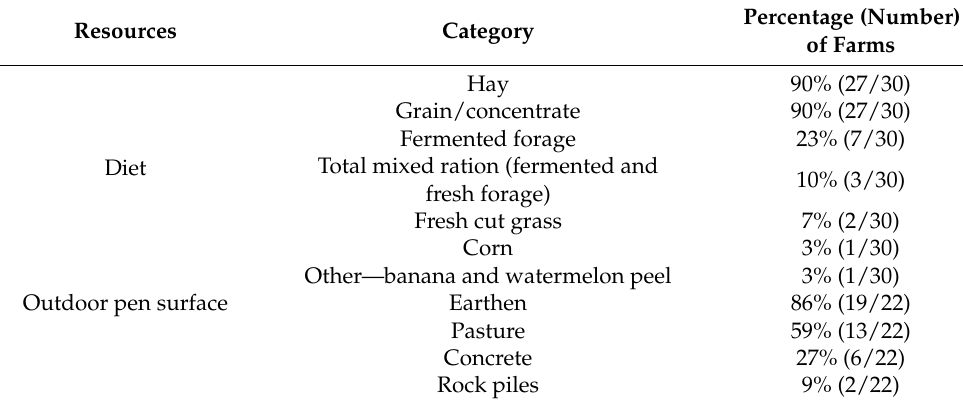
Table 2. Dairy goat producer responses relating to resource